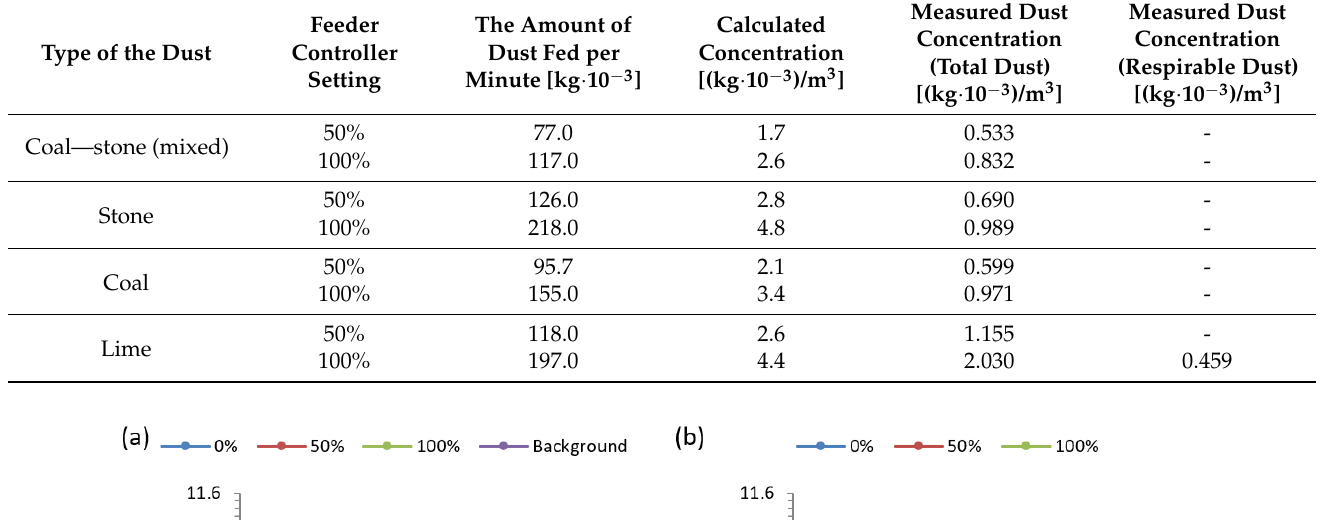
Table 2. Values of dust concentration inside the tunnel during tests with AR41 transducers.